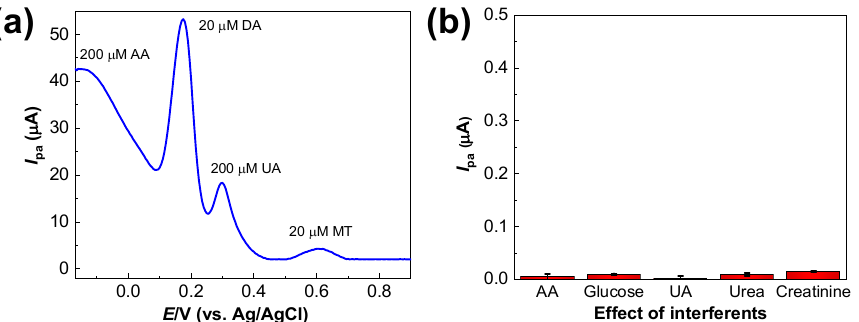
Figure 11. ( a ) Selectivity results of the Cu–CNS/SPCE for the simultaneous determination of DA and MT in the presence of a ten-fold excess of various interfering compounds (AA, glucose, UA, urea, and creatinine). ( b ) Effect of other common interferents in DA and MT determination.